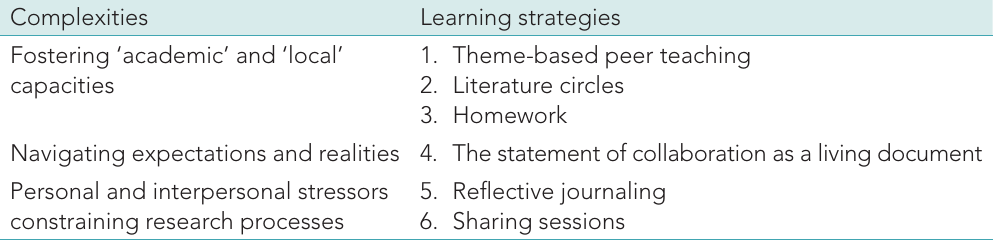
Table 1: Learning strategies to address complexities within co-researching teams